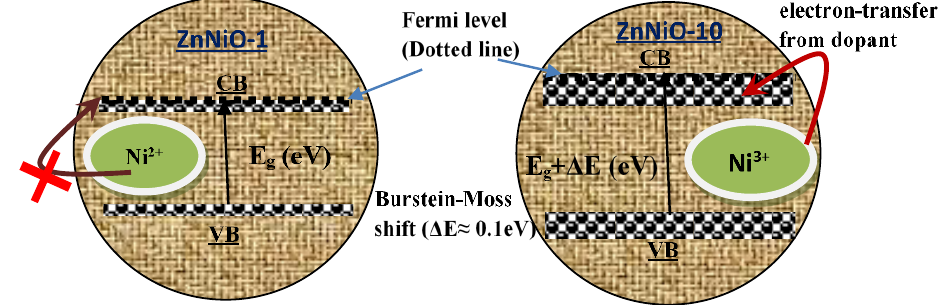
Figure 5. Optical transition processes taking place di ff erently in ZnNiO nanoparticles with l% and 10% Ni doping levels. Higher Kubelka-Munk function values F(R) are expected in UV-blue region for the optical transition shown in right-side schematic of the figure.